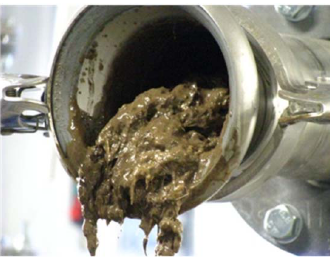
Figure 1. Crushed and ground animal waste prepared for